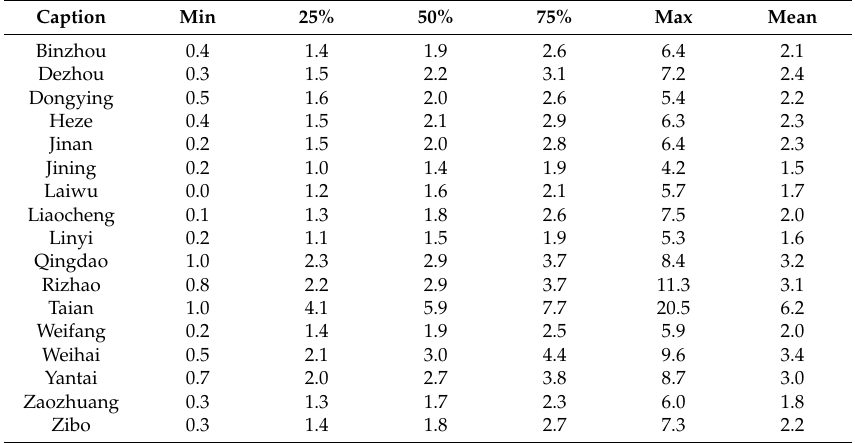
Table A7. Descriptive statistics of the daily mean wind speed (m/s) in the 17 cities of the Shandong province (from 1 January 2015 to 31 December 2016).